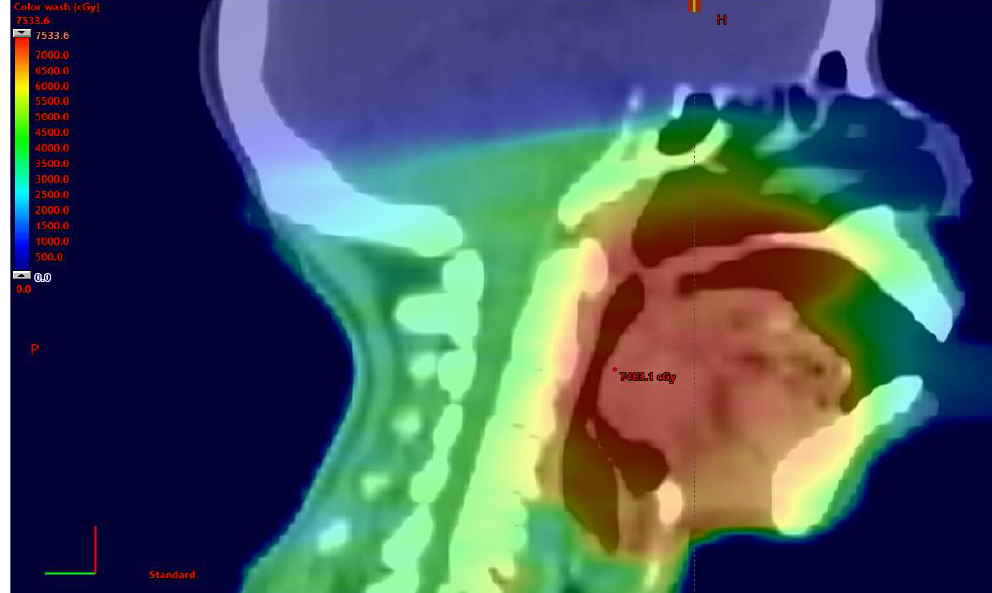
Figure 1. Depiction of a radiation therapy plan for a patient who was treated with a dose of 70 Gray for a squamous cell carcinoma of the right tonsil. Note the significant radiation doses delivered to the surrounding normal tissues.